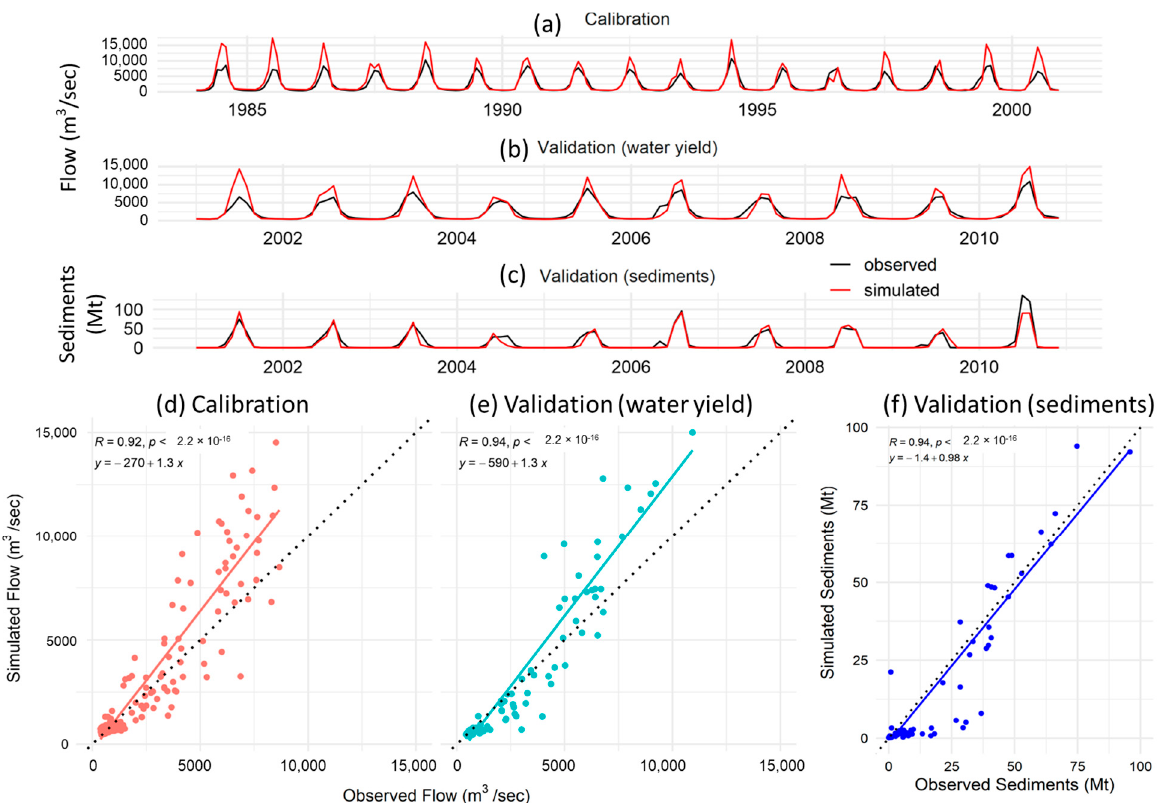
Figure 5. SWAT model calibration and validation results. ( a ) time series of observed and simulated flow during calibration period. ( b ) time series of observed and simulated flow during validation period. ( c ) time series of observed and simulated sediments during validation period. ( d ) observed versus simulated flow during calibration. ( e ) observed versus simulated flow during validation. ( f ) observed versus simulated sediments during validation